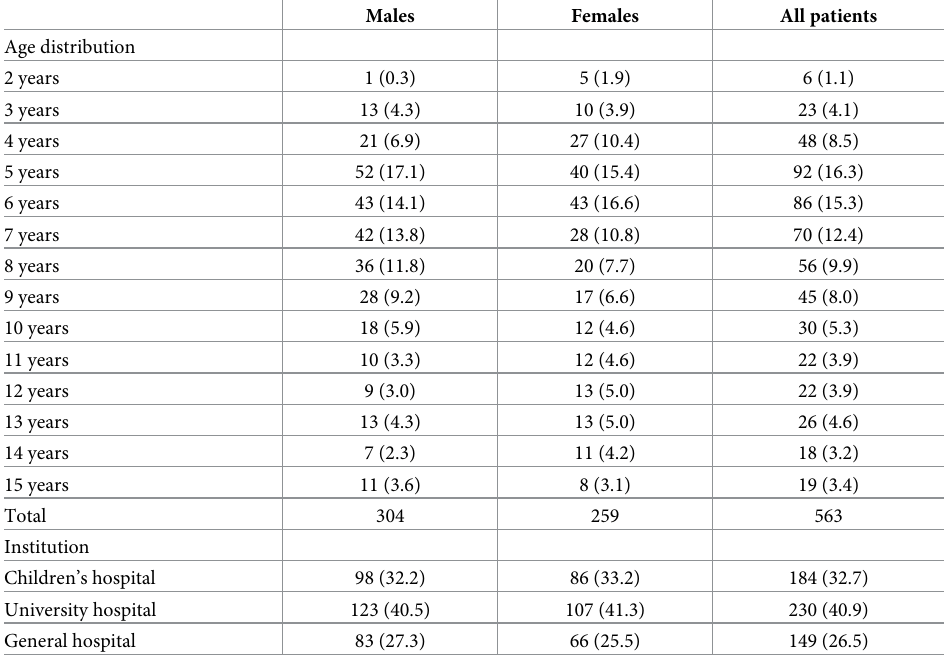
Table 2. Patient characteristics.